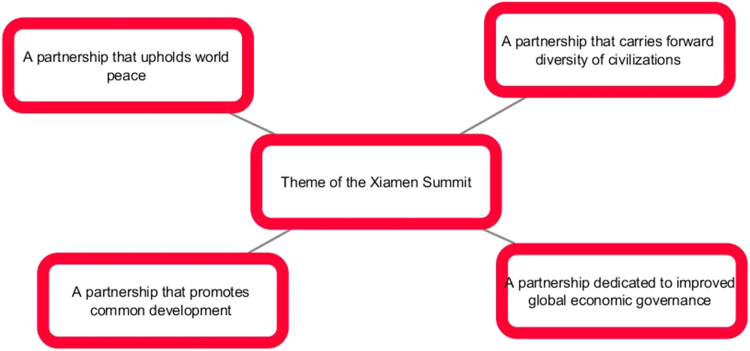
The theme of Xiamen summit in 2017 [3].